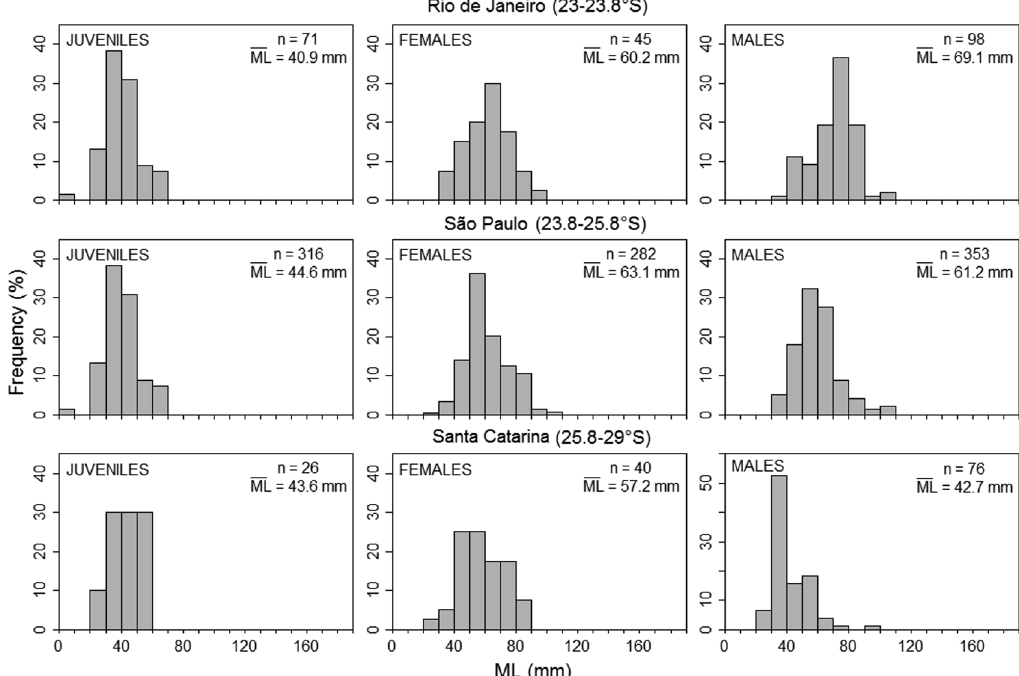
Figure 6. Size structure of Doryteuthis sanpaulensis according to the subareas nested within the SBB (22–29°S). Note de different y-axis. ZOOLOGIA 35: e23176 | DOI: 10.3897/zoologia.35.e23176 | October 4,